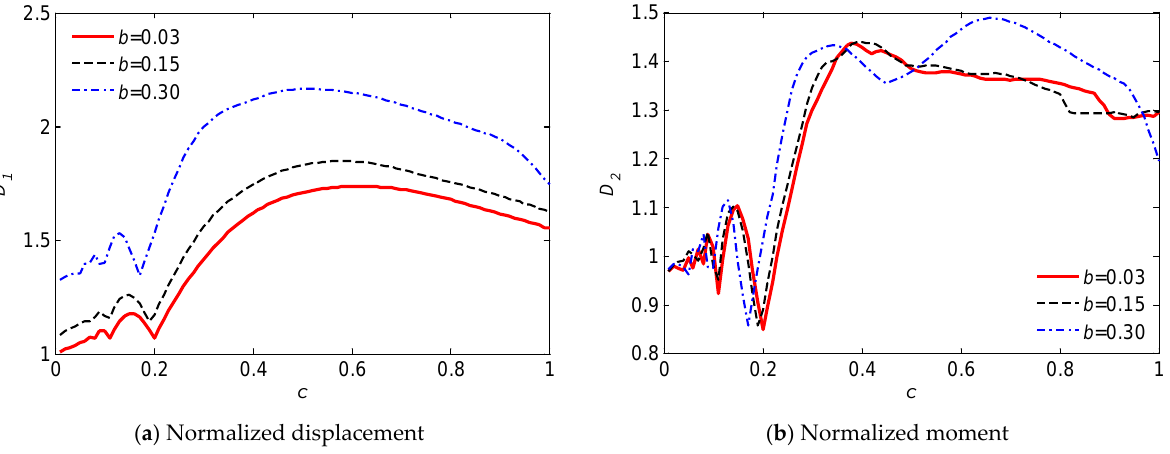
( D 1 ) = 1.738 for c = 0.62 and max ( D 2 ) = 1.437 for c = 0.38. For lower values of the ratio c , that is c ≤ 0.20, the magnification factors in Figure 6 both increase and decrease with increasing c . For higher c values, c > 0.62 and c > 0.38 respectively, D 1 and D 2 decrease in the present problem.